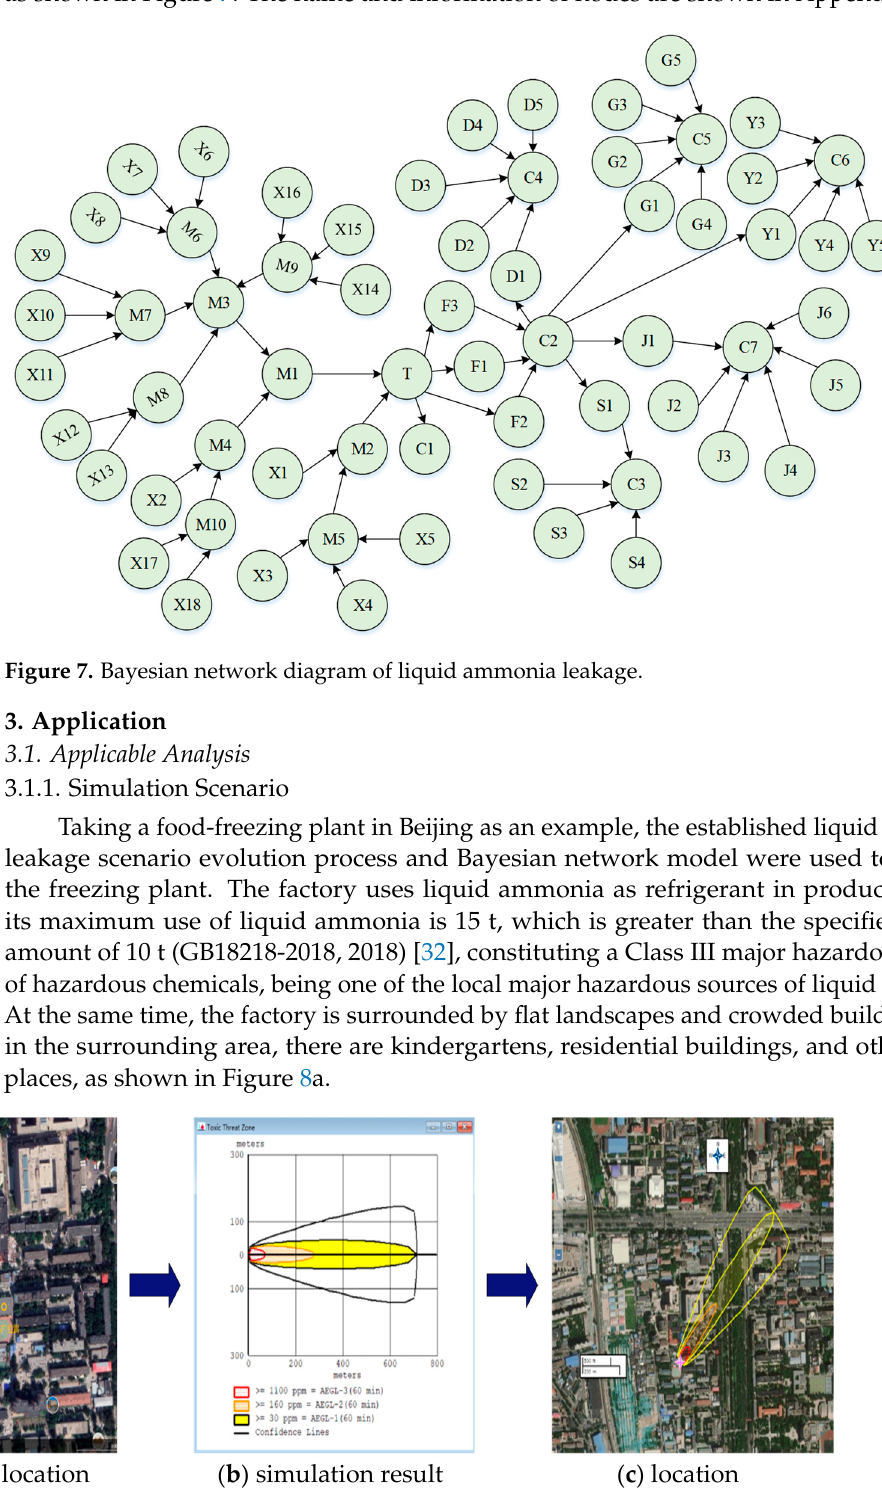
Figure 8. Factory location and simulation results group figure ( a – c ).